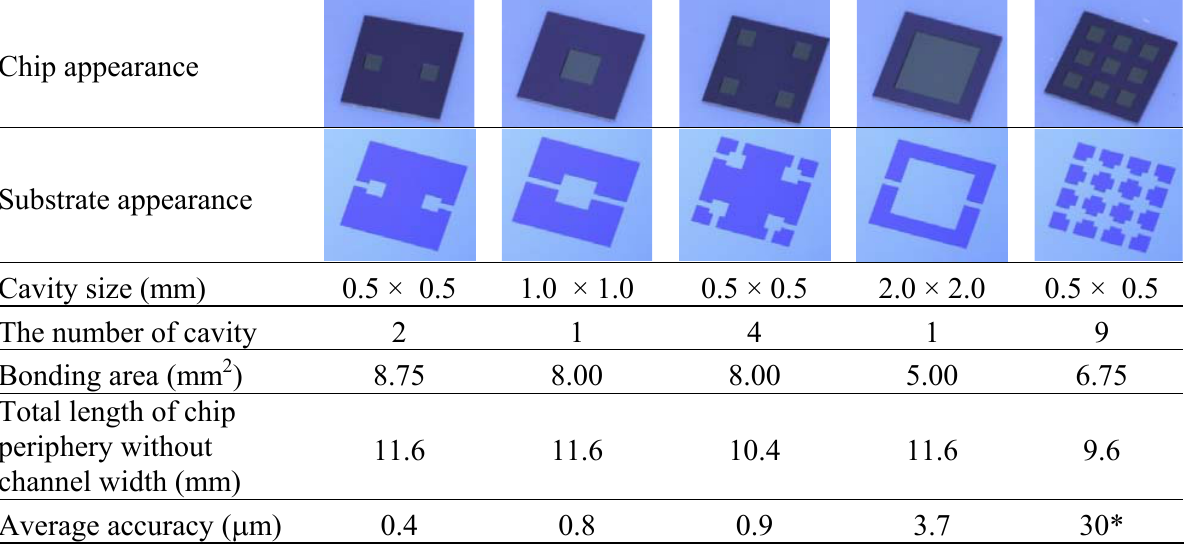
Table 1. Chip and substrate specification and the obtained alignment